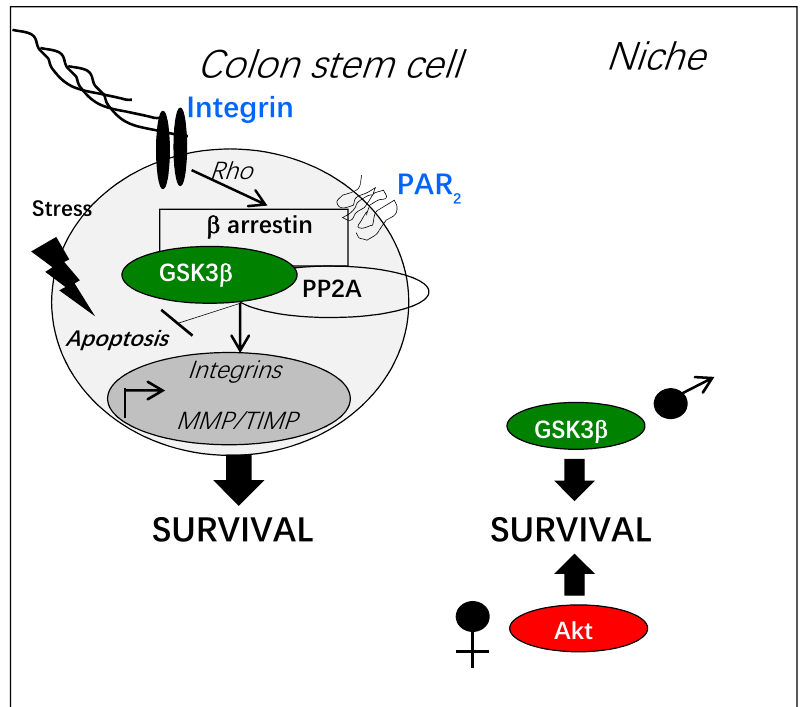
Figure 4. PAR 2 -dependent activation of GSK3 β in normal colon stem cells. PAR 2 activation by protease-dependent cleavage can induce a β arrestin-dependent signaling pathway resulting in GSK3 β activation through its de-phosphorylation by the phosphatase PP2A. This signaling pathway is controlled by the Rho kinase activated by adhesive stress. Gene transcription of integrins, metalloproteases (MMP) and their inhibitors (TIMP), is regulated by the PAR 2 /GSK3 β pathway. Active GSK3 β counteracts stress-induced apoptosis by multiple mechanisms (see Section 3, “GSK3 β and key functions of adult stem cells”). In the physiology of colon stem cells, the pro-survival signaling of PAR 2 is sexually dimorphic depending on GSK3 β or on